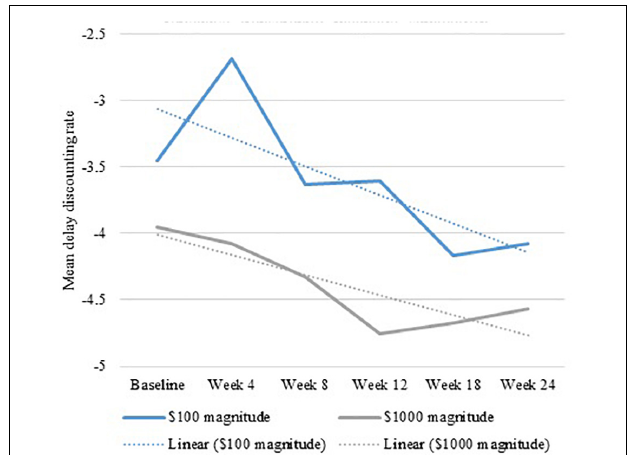
FIGURE 3 | Generalized estimating equation show an overall decrease in delay discounting rate over 6 months of repetitive transcranial magnetic